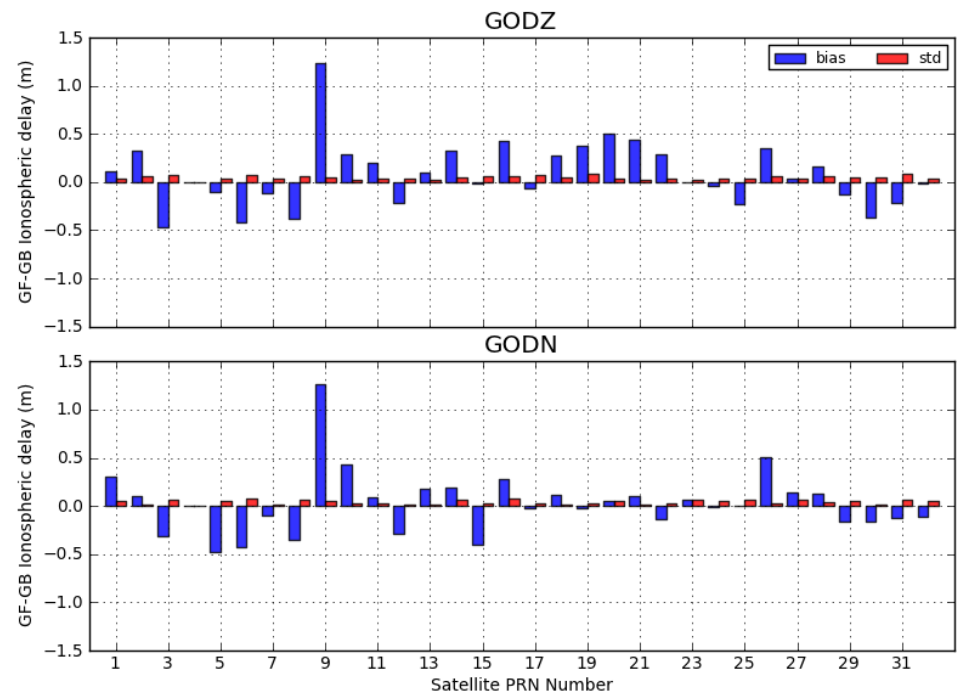
Figure 7. Biases and standard deviations of GF–GB ionospheric delays for all of the observed satellites computed from the receiver GODZ ( top ) and GODN ( bottom ) observations with real-time OC products.